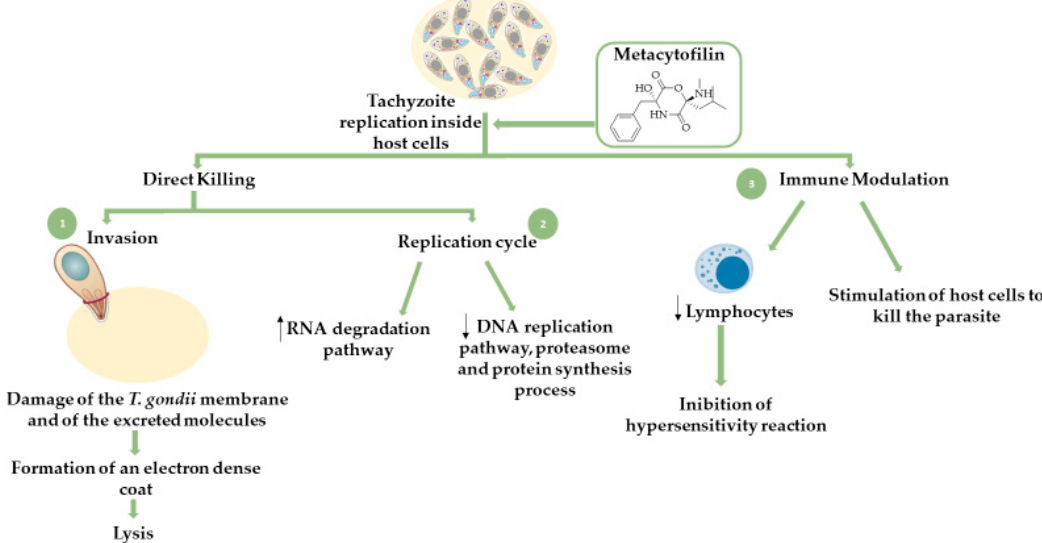
Scheme 2. Schematic representation of the mechanism proposed for the action of metacytofilin on T.